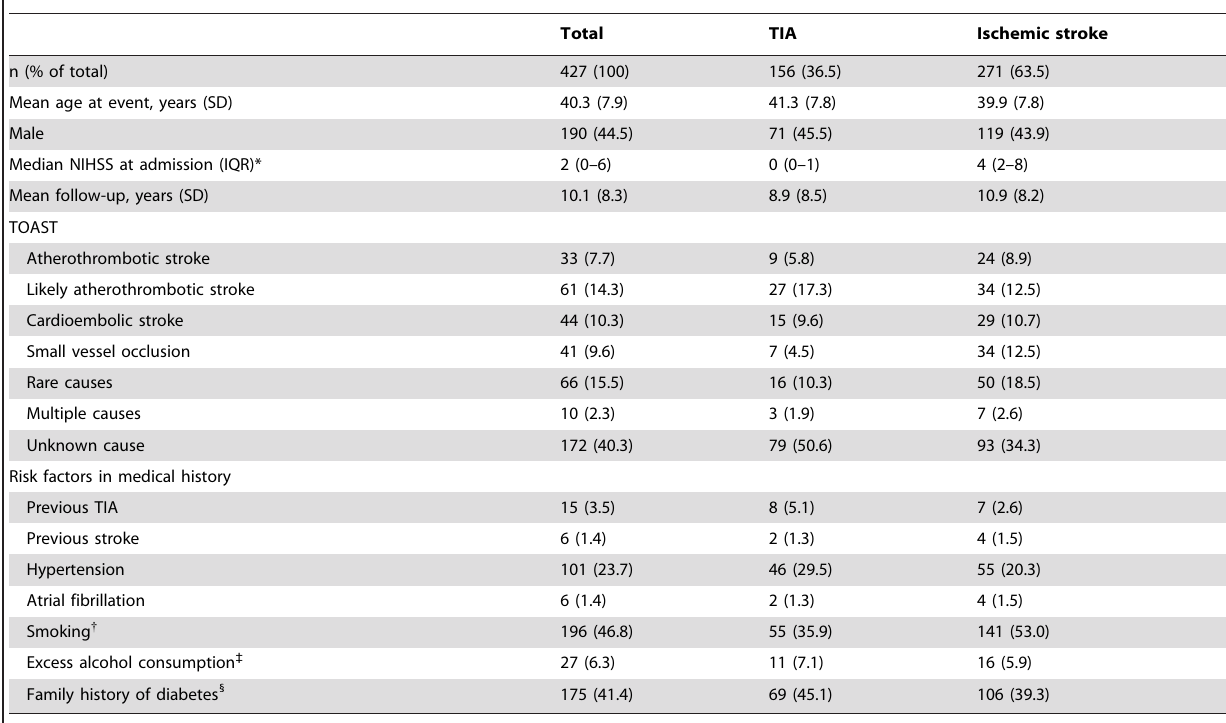
Table 1. Baseline characteristics of